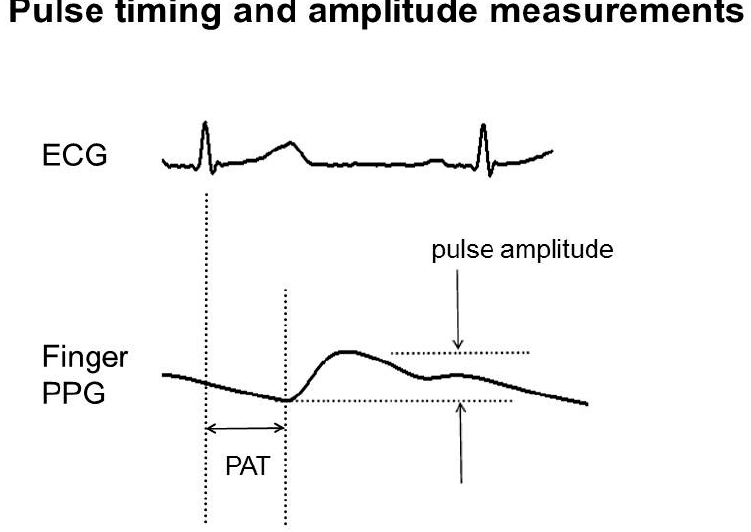
Figure 3. Example PPG pulse arrival time (PAT) and amplitude measurements for a single pulse from the finger site. Amplitude is normalized by dividing by the associated amplifier gain setting. Timing and normalized amplitude measurements are subsequently resampled at 4 Hz for the time and the frequency domain analyses.